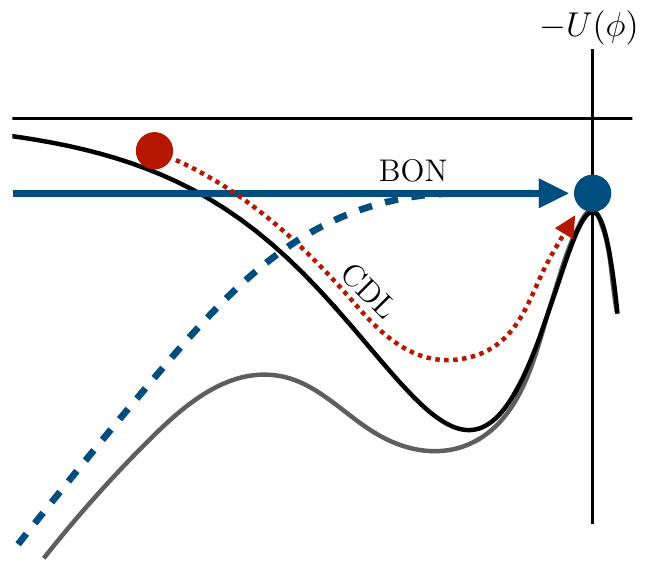
Figure 4 . A diagram comparing the BON and CDL boundary conditions. The BON initial conditions φ (0) → −∞ , φ 0 → + ∞ ensure that φ ( ξ ) quickly approaches the false vacuum. Its approach to φ ( ξ ) → φ is determined by the details of the potential, which is approximately fv quadratic in the neighborhood of φ ≈ φ . This direct approach to φ is indicated by the straight fv fv blue line in the figure. The CDL solution, on the other hand, begins at finite φ (0) = φ with CDL φ 0 (0) = 0 . It subsequently “rolls” in the inverted potential, as indicated by the dashed red line, until it approaches φ . In the dashed blue line we show a second BON example, one in which the fv potential U ( φ → −∞ ) diverges (with − U ( φ ) shown in dark gray). The φ 0 (0) → ∞ BON initial conditions can compensate for the divergence in U ( φ ) , so that there is a BON solution even if there is no corresponding CDL solution for that